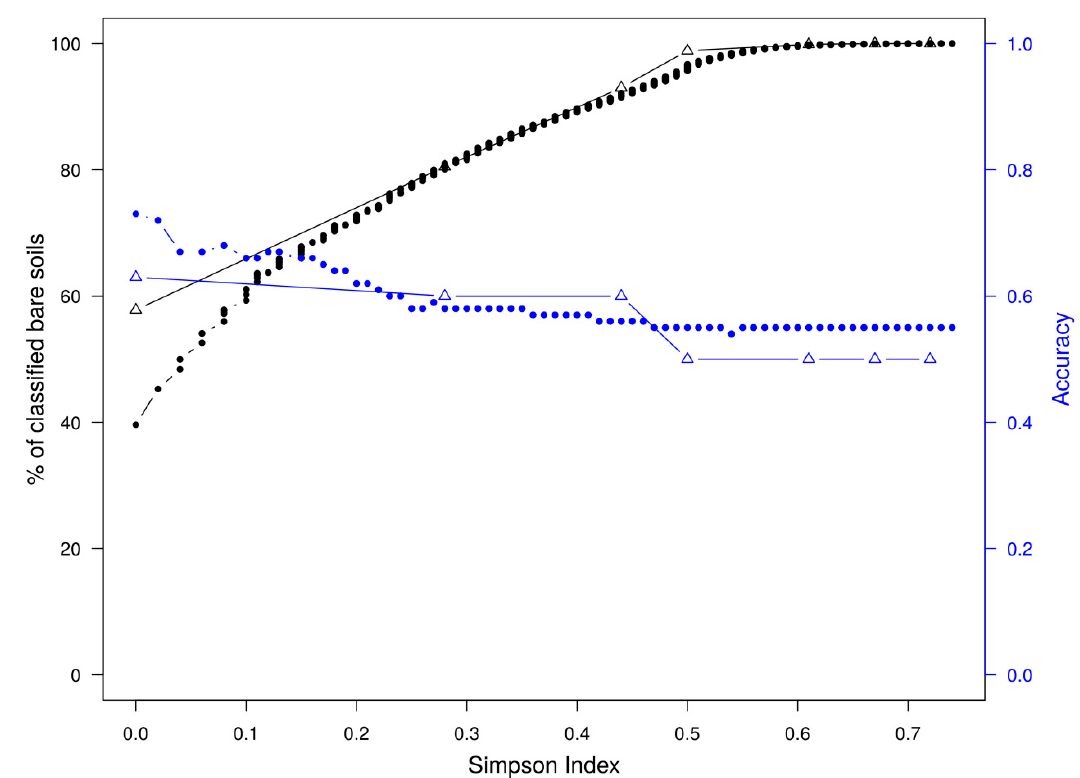
Figure 10. Proportion of classified bare soil pixels and classification performance (accuracy), versus a maximal value of SI allowed. Triangles correspond to results obtained from the set of six classifications. Circles correspond to results obtained from the bootstrap process applied to the image acquired on 24th of April.